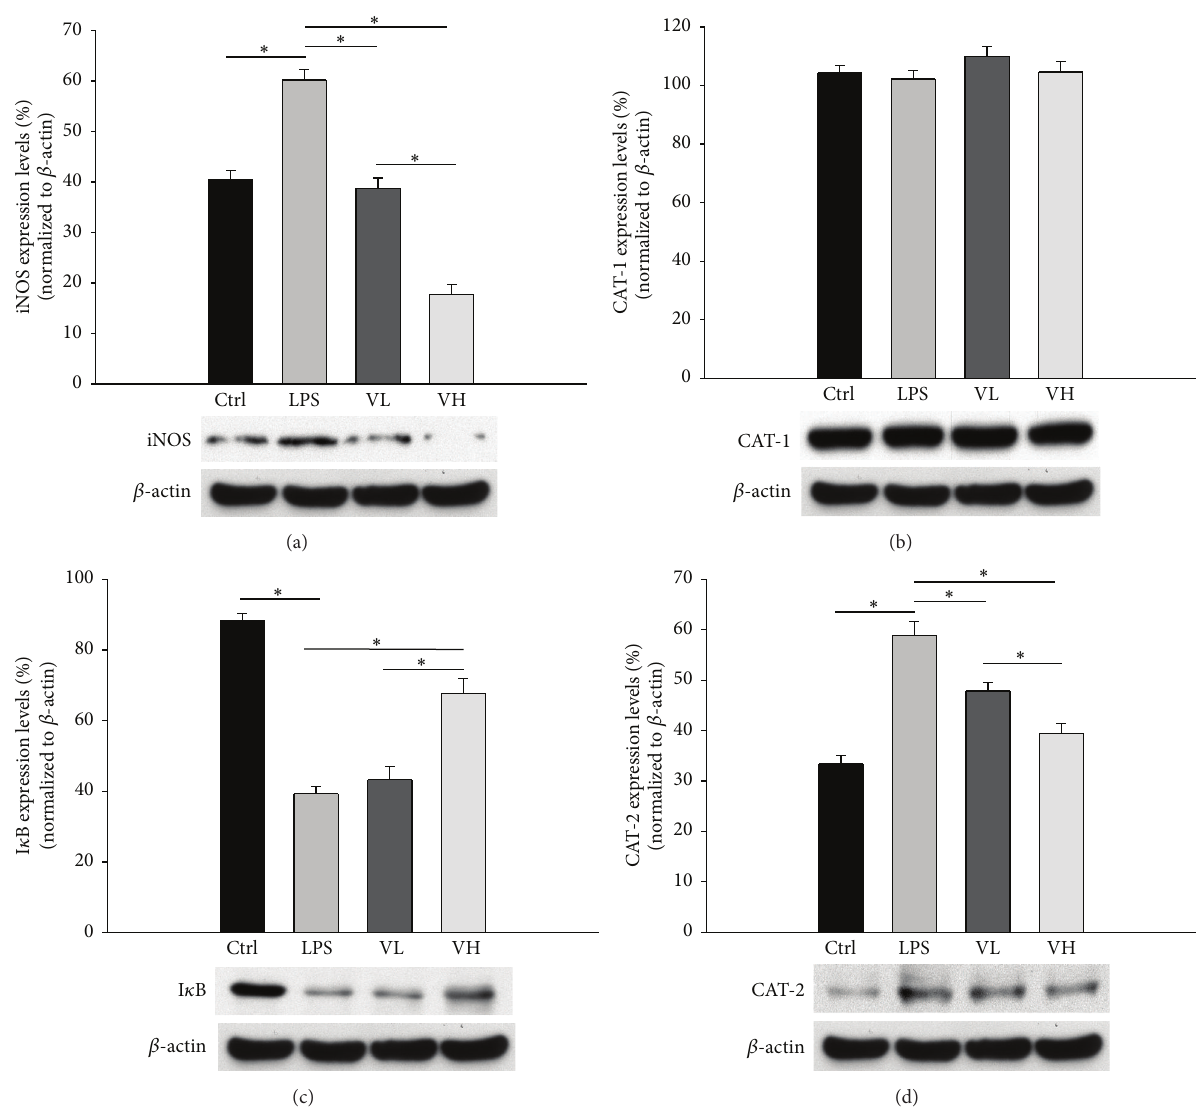
Figure 7: CAT, iNOS, and I 𝜅 B protein levels in RAW 264.7 cells. The cells were grouped into control conditions (Ctrl), treatment with LPS (LPS), and pretreatment with 10 nM bortezomib (VL) or 25 nM bortezomib (VH). The protein levels of iNOS, I 𝜅 B, CAT-1, and CAT-2 were analyzed by western blotting. The symbol “ ∗ ” indicates statistical